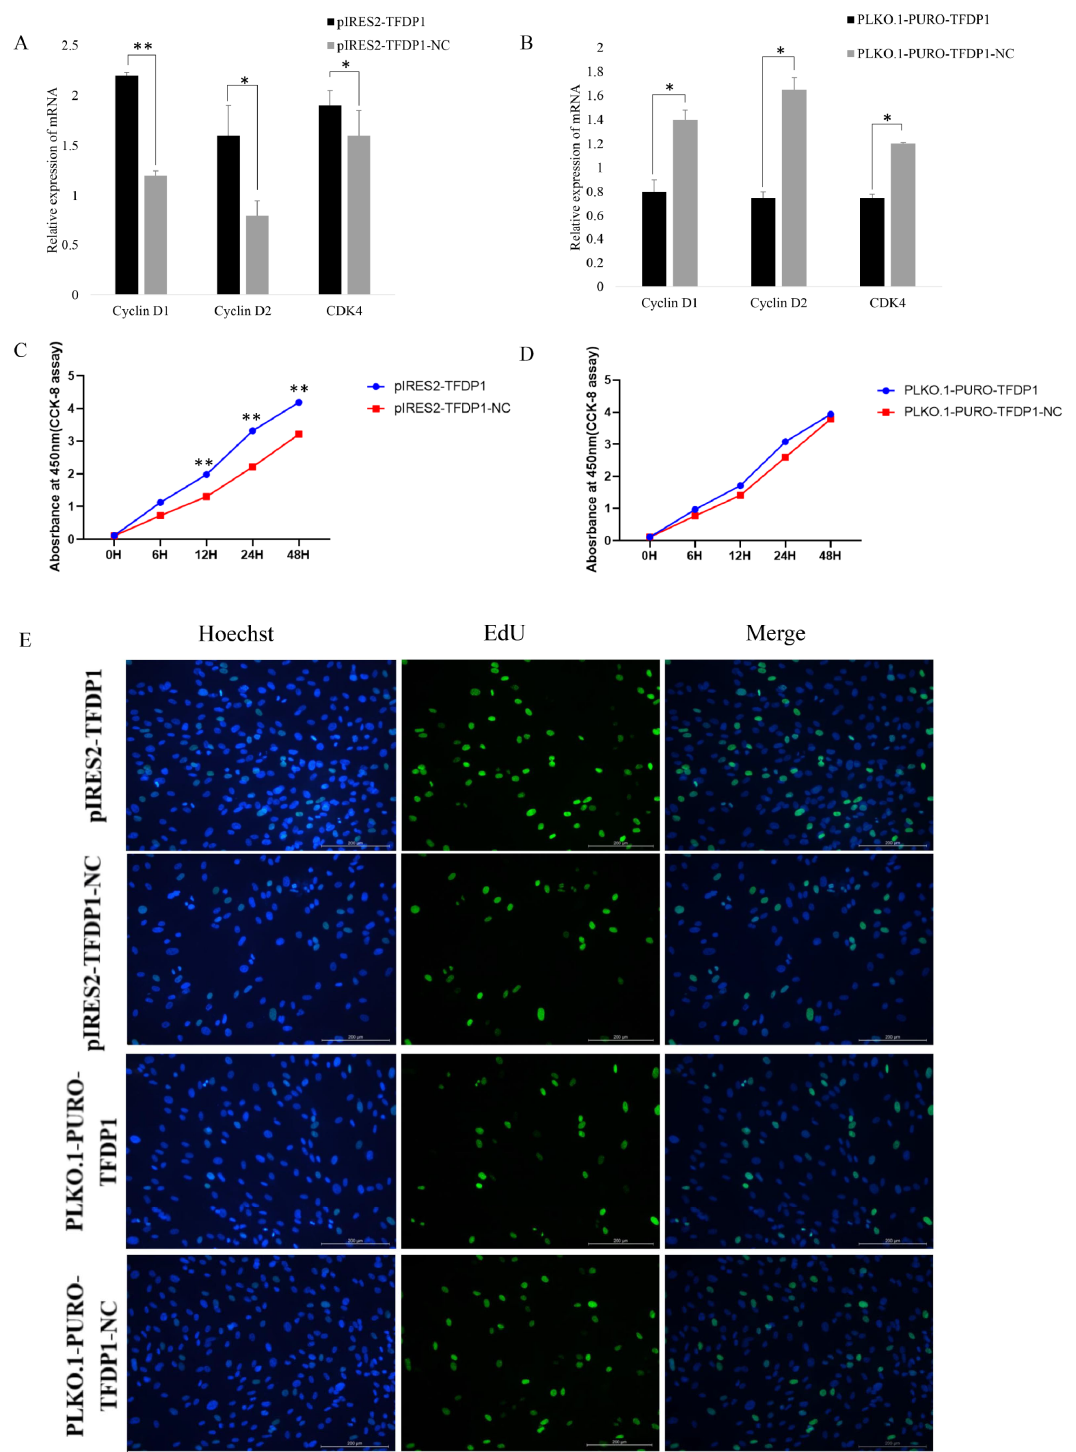
Figure 6. The transcription factor TFDP1 regulated the proliferation of goat GCs. ( A , B ): The expres- sion of proliferative factors after TFDP1 overexpression and interference, respectively, in goat GCs. ( C , D ): The CCK-8 results. ( E ): The EdU assay of GC proliferation. * p < 0.05; ** p <